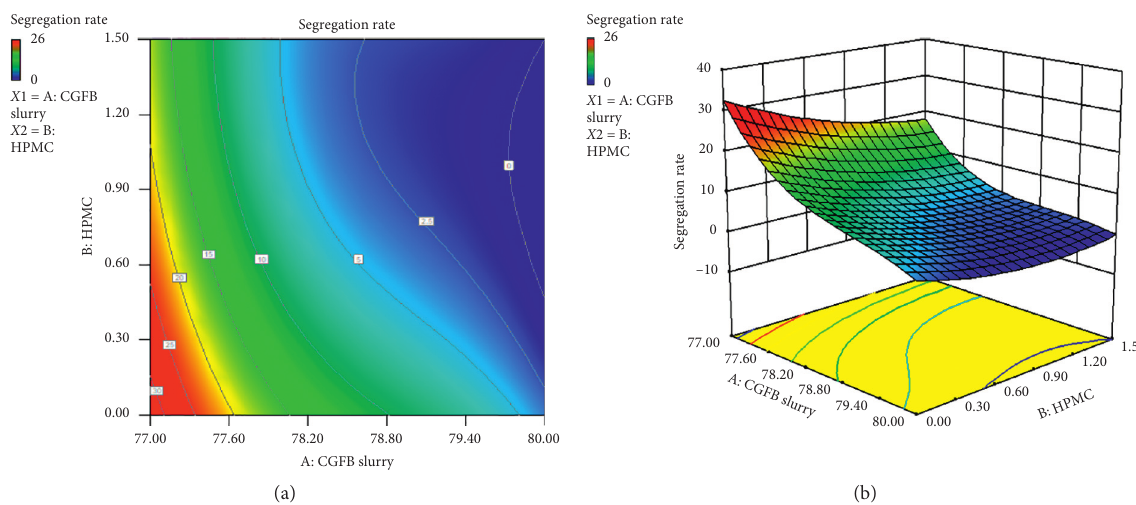
Figure 6: Response surface plot of segregation. (a) Two-dimensional diagram. (b) Three-dimensional diagram.